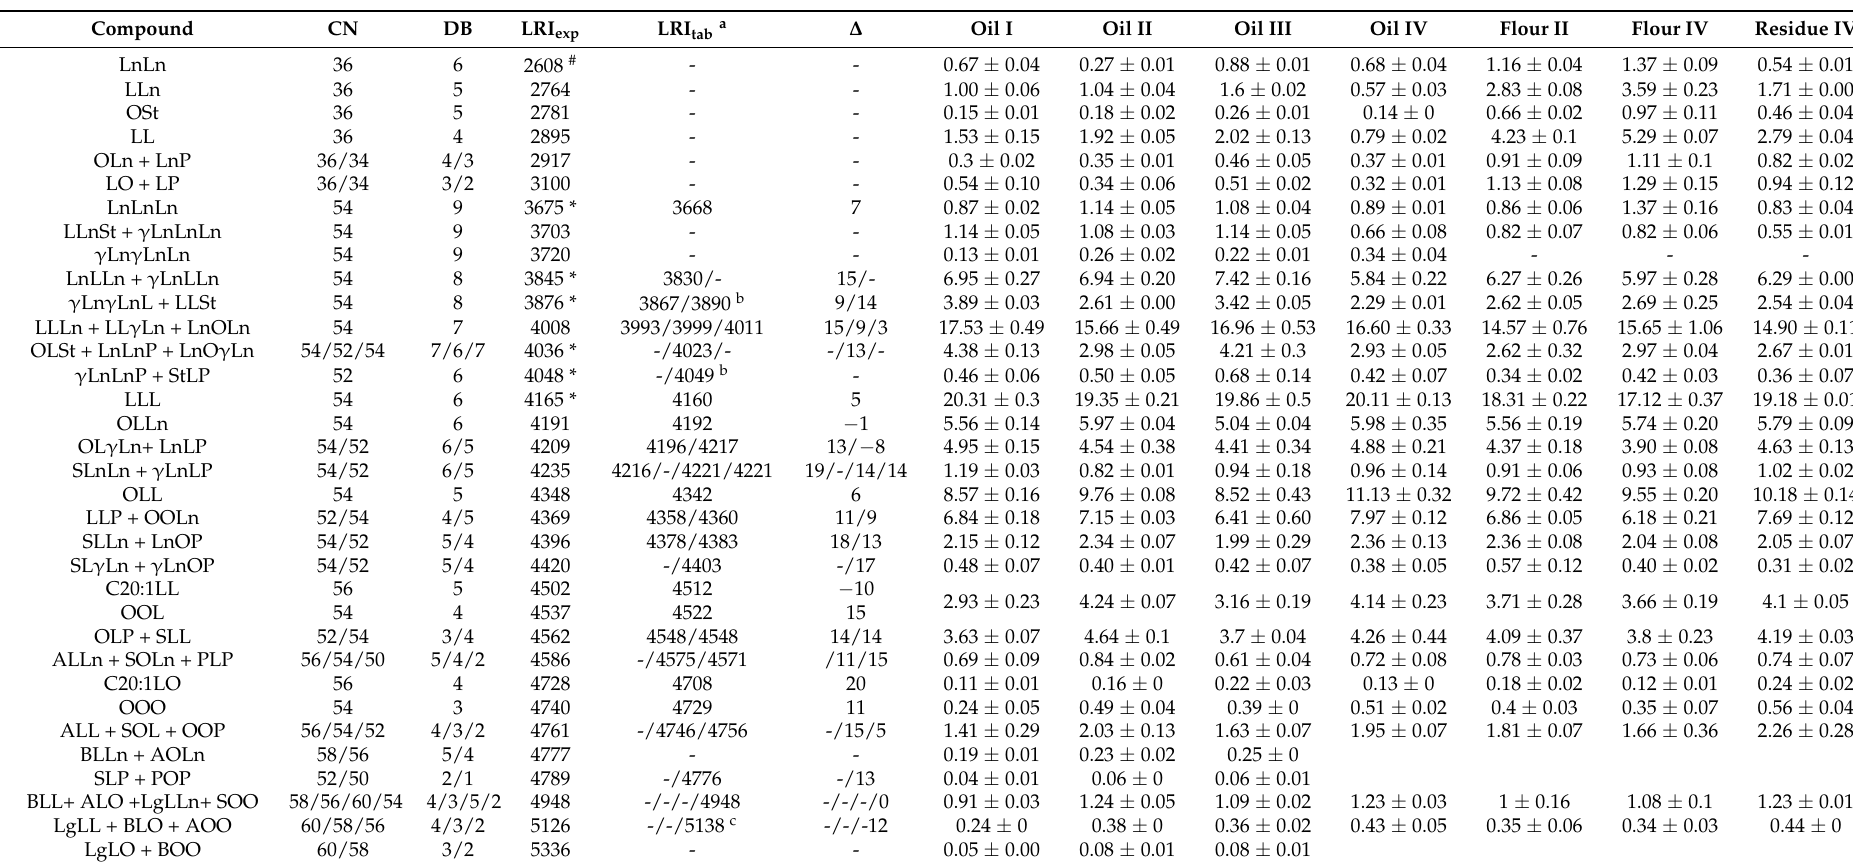
Table 2. List of identified glycerolipids in the lipid fraction of the hempseed-derived products, along with the PN, total carbon number (CN) and double bonds (DB), experimental (LRI exp ) and theoretical LRI (LRI tab ) values and their difference ( ∆ ) and relative content